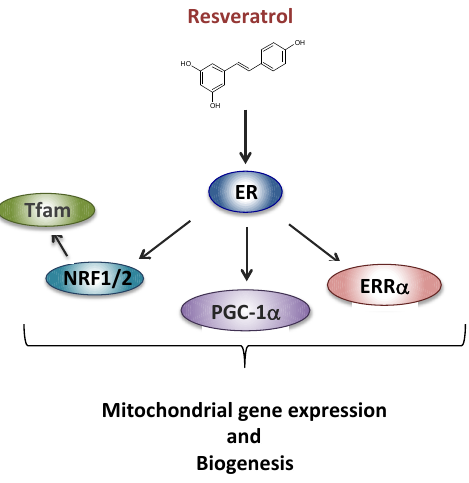
Figure 2. Proposed signaling pathway for the effect of resveratrol involving ER (estrogen receptor). Estrogen related receptor alpha (ERR α ), PPAR gamma co-activator 1 alpha (PGC-1 α ), nuclear respiratory factors 1 and 2 (NRF1, NRF2), mitochondrial transcription factor A